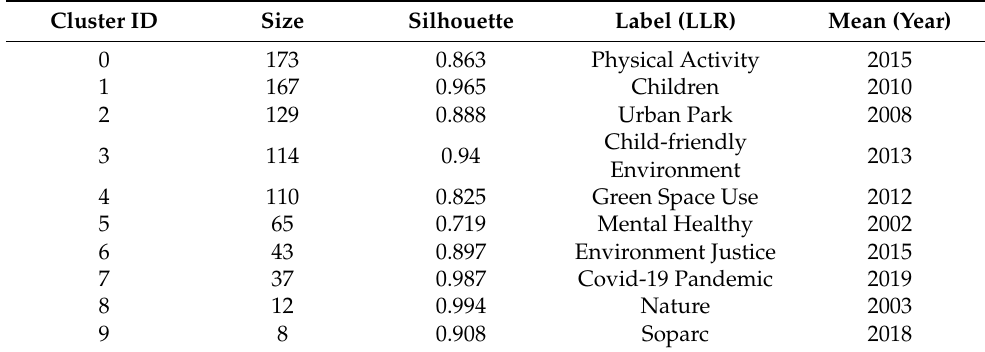
Table 2. Summary of the largest 10